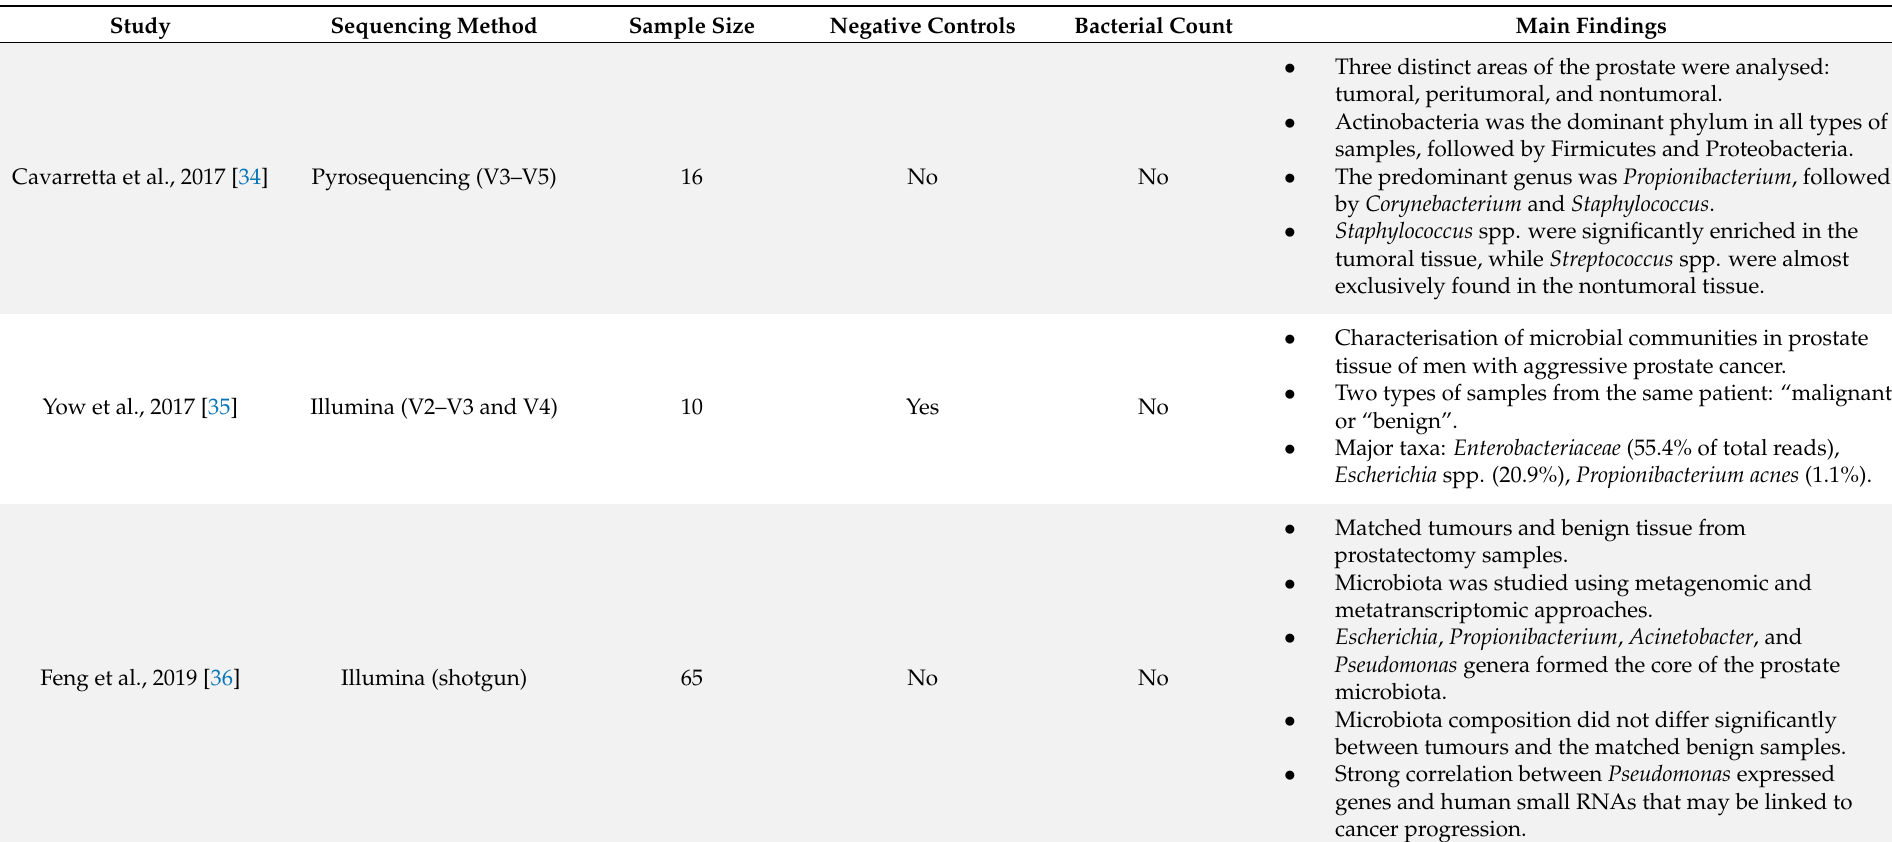
Table 1. Characterisation of prostatic tissue microbial communities using